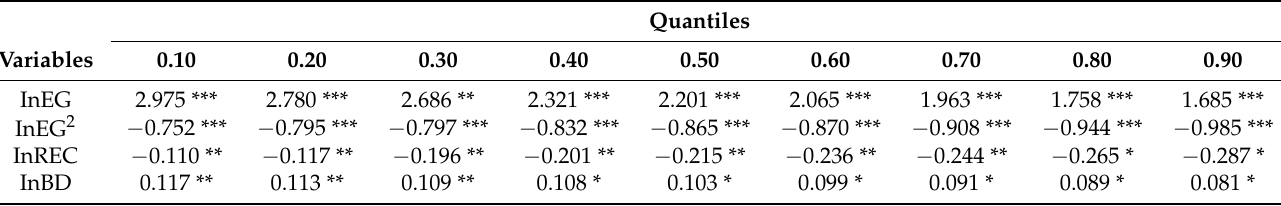
Table 8. The findings of the MMQR